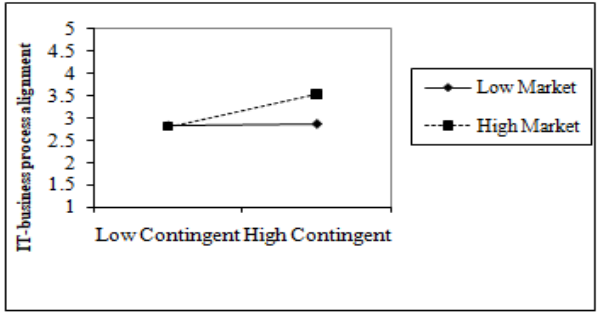
Figure 3. Contingent reward * market culture.